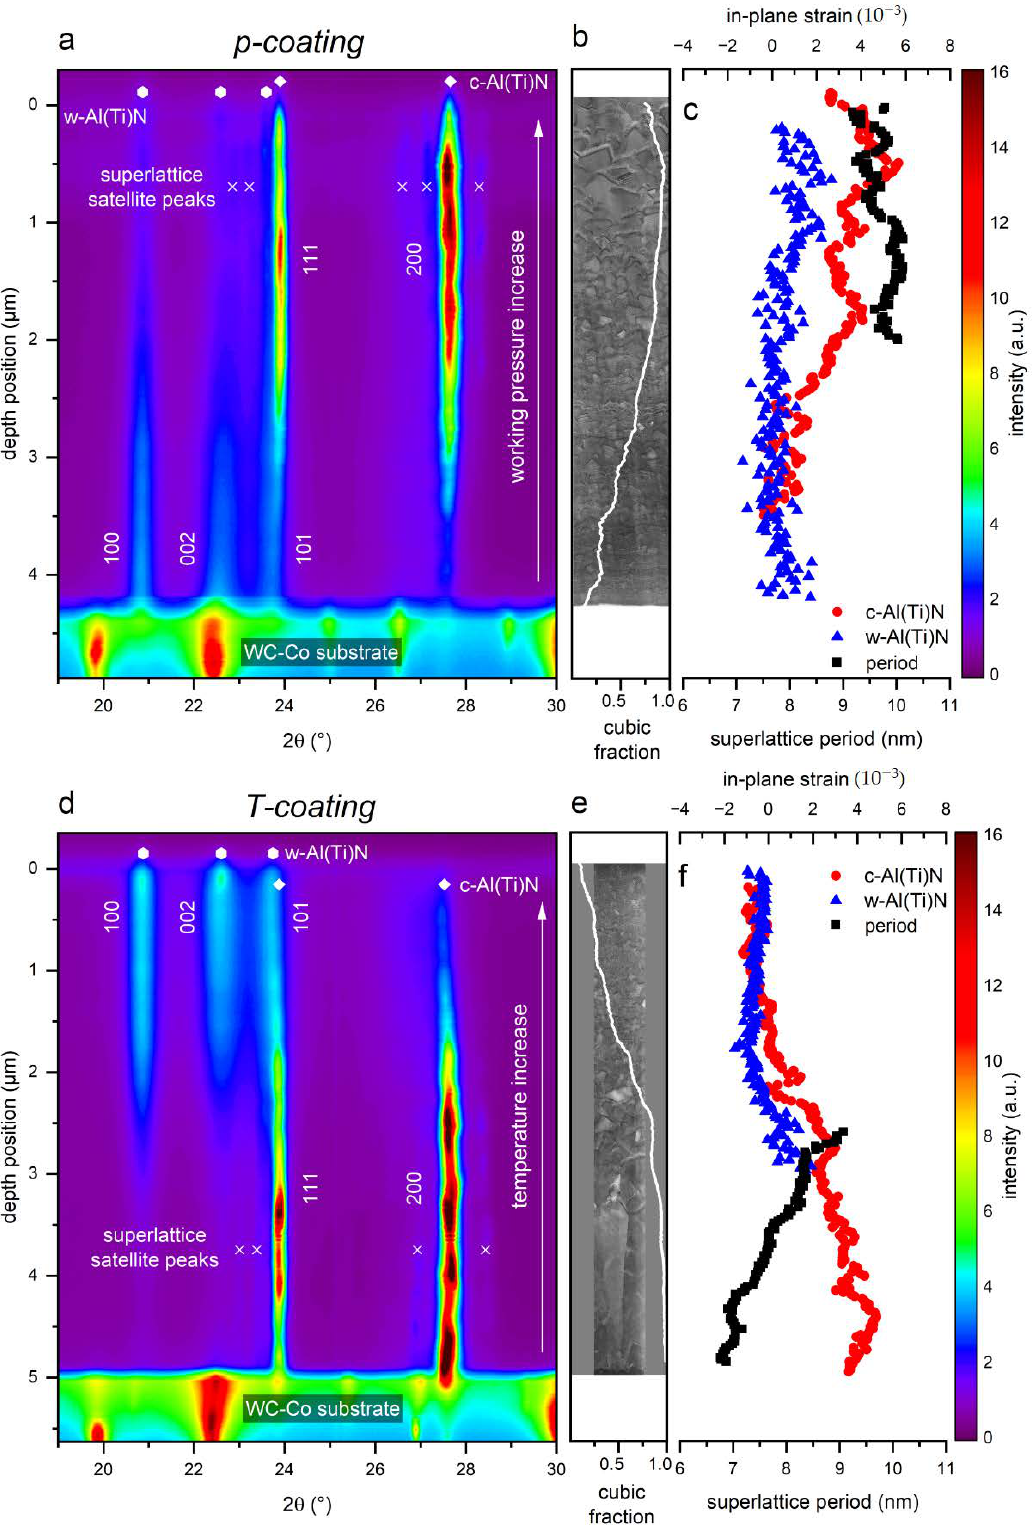
Figure 4. Results from scanning cross-sectional X-ray nanodiffraction (CSnanoXRD) indicate the evolution of phases across cross-sections of the p- ( a ) and T-coating ( d ). In ( b , e ), the cubic phase fraction is presented. In ( c , f ), cross-sectional evolutions of in-plane strains in cubic (prefix c) and hexagonal (prefix w) Al x Ti 1 − x N phases, as well as the superlattice period of the cubic nanolamellae, are